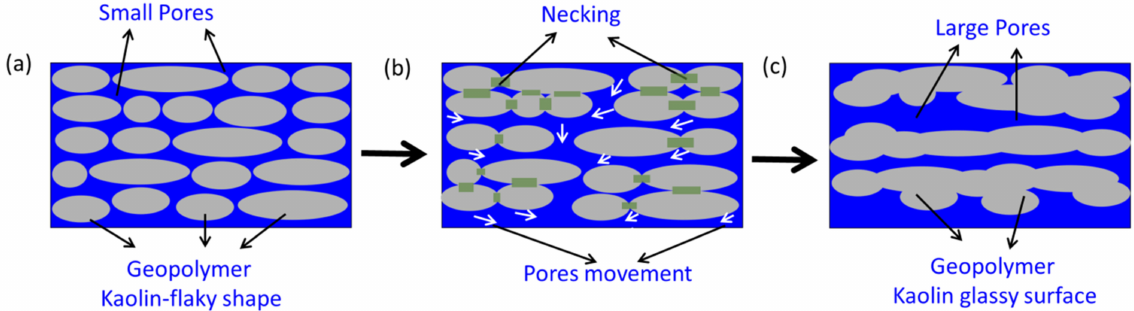
Figure 7. Sintering mechanism of pore transformation in various environments: ( a ) unsintered,